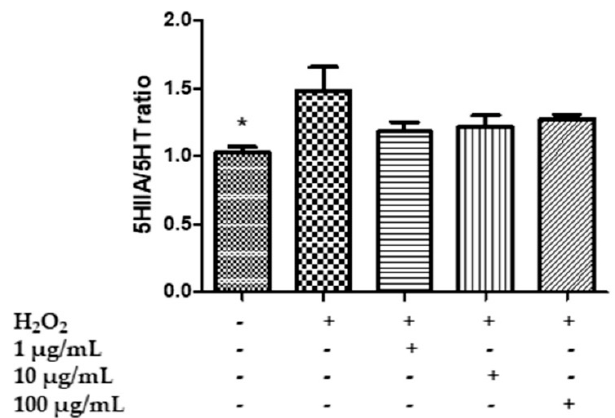
Figure 4. Effect of the HAE acetone water extract (1–100 µ g/mL) on serotonin turnover, measured as 5HIIA/5-HT ratio, in hypothalamic HypoE22 cells exposed to H 2 O 2 ( µ M). ANOVA p < 0.01; * p < 0.05 vs. H 2 O 2 .